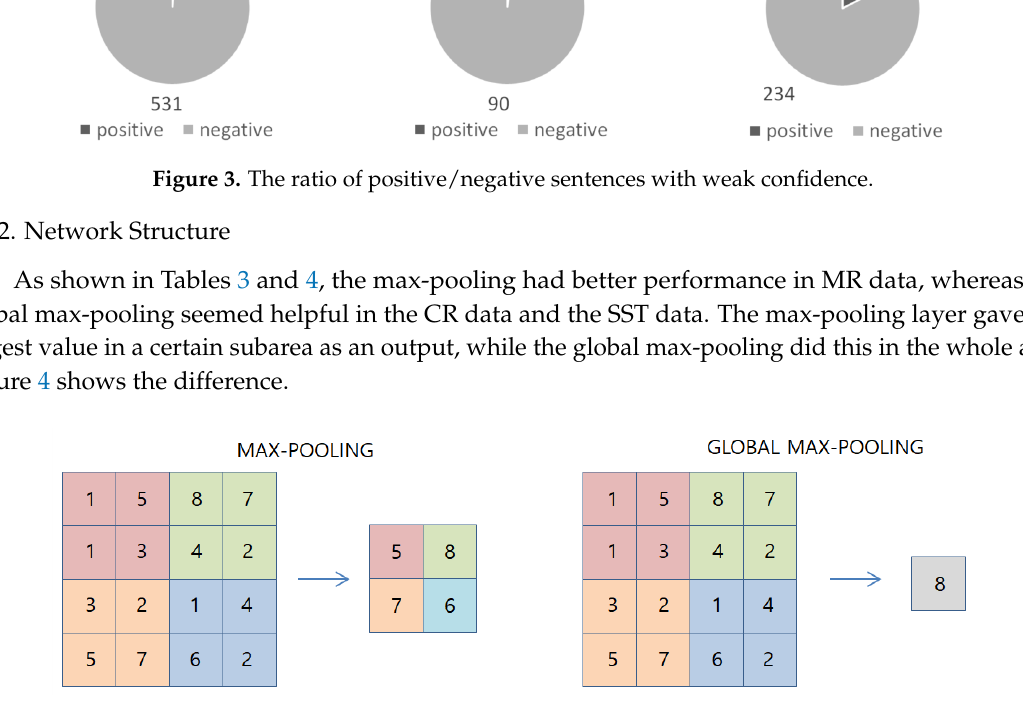
Figure 4. The difference of max-pooling and global